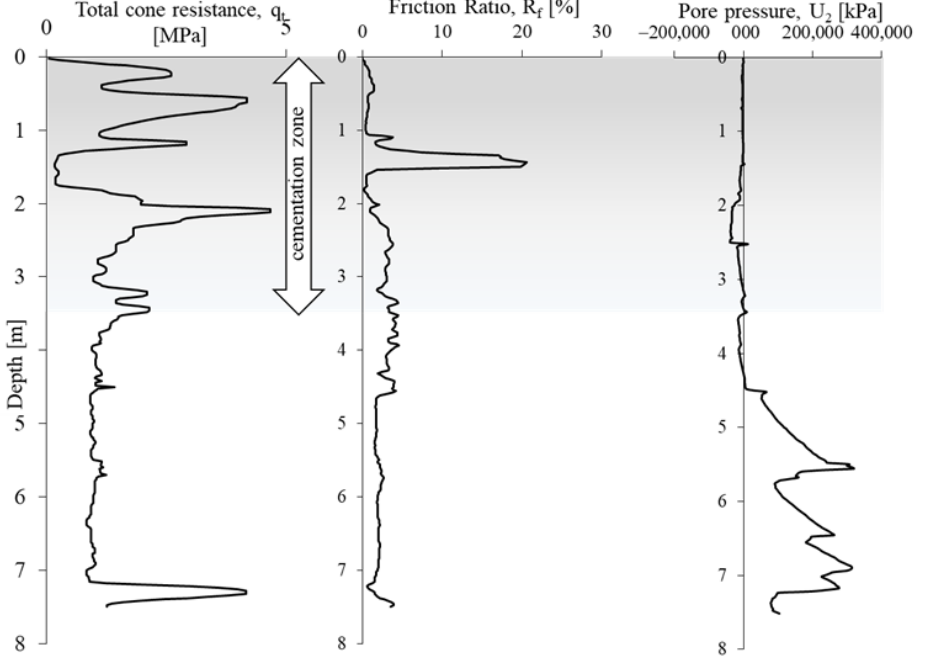
Figure 5. Examples of in situ tests on the researched area A.